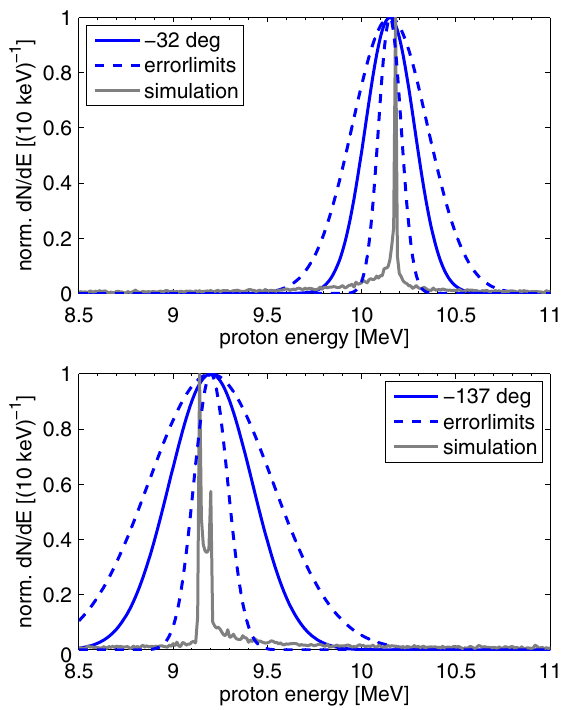
FIG. 6. The measured and simulated particle spectra for Φ ¼ − 32 deg and Φ s